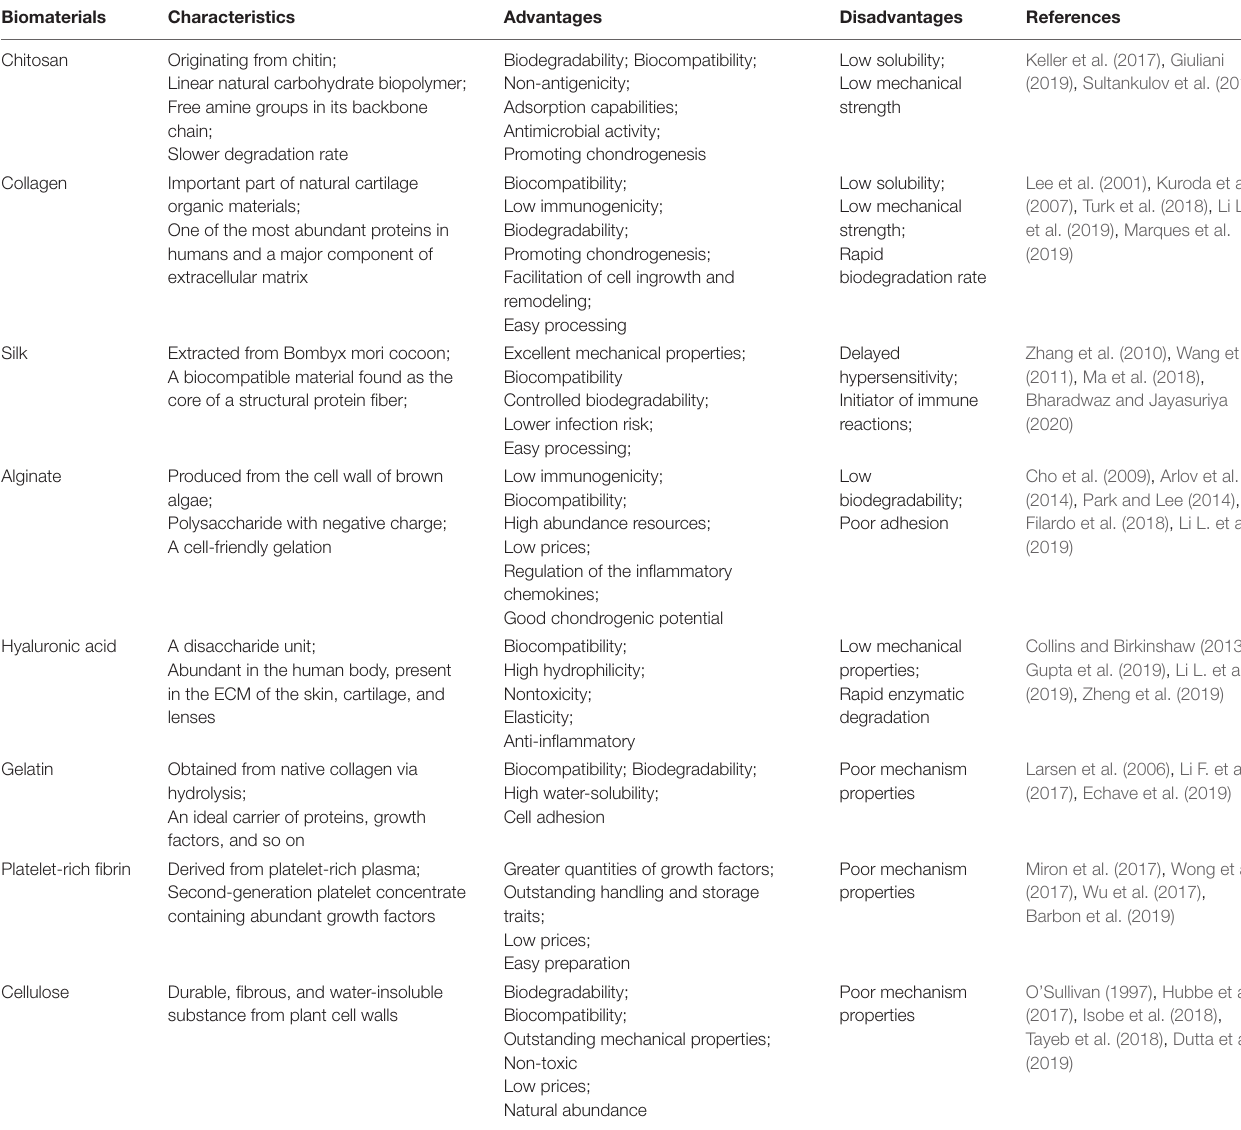
TABLE 1 | Characteristics of the outlined natural polymers for